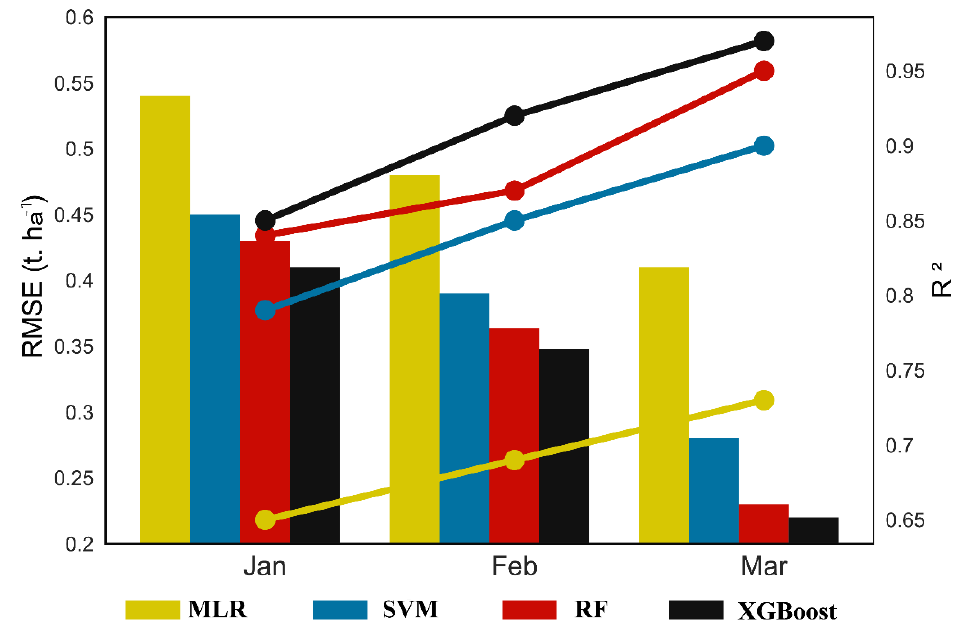
Figure 3. Model performance (R 2 -line- and RMSE -bar-) as a function of the lead time from 4 to 2 months before havers (from January to March) for the four methods (MLR, SVM, RF and XGBoost). All the available predictor variables at the time of prediction were used (see Table 2).